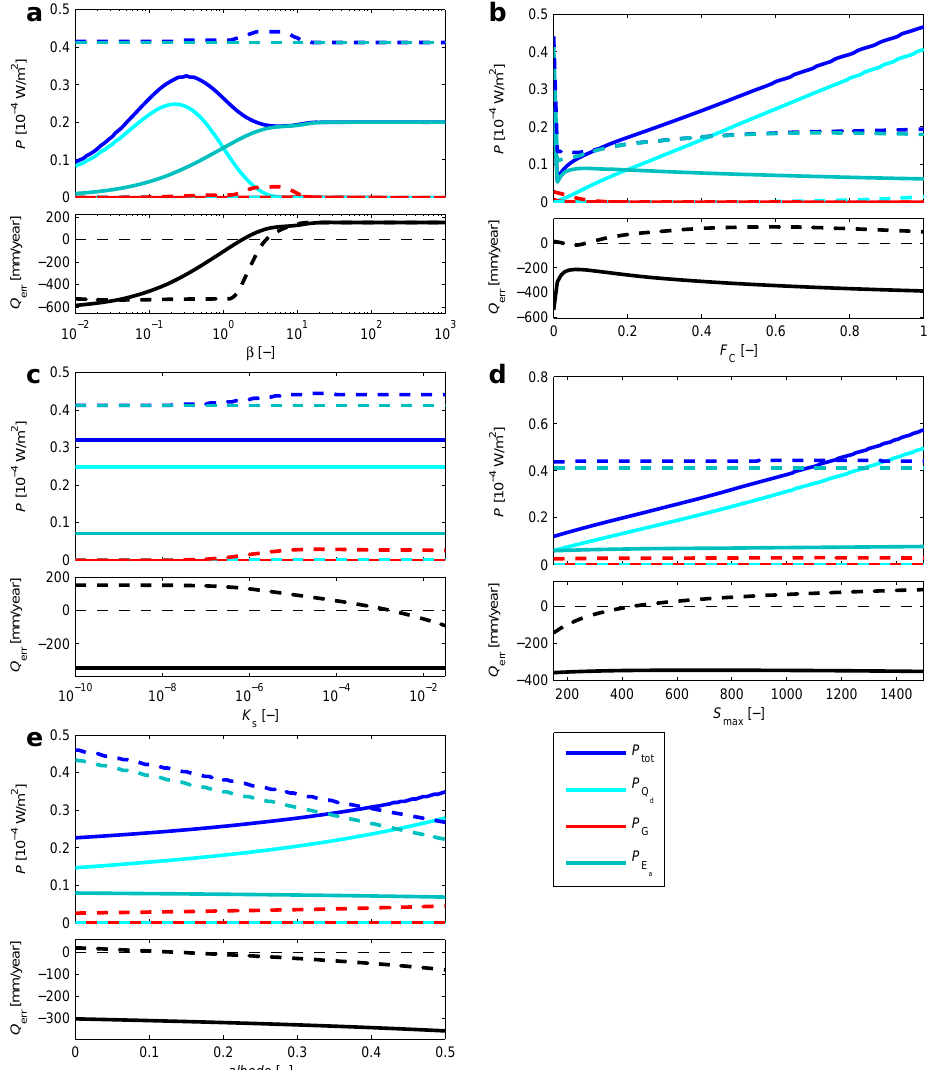
Fig. 3. Sensitivity of (a) β , (b) F C , (c) K s , (d) S max and (e) albedo to power of the different fluxes leaving the unsaturated zone and associated mass balance error for the Weiherbach catchment. Total power is plotted in blue, power by Q d in light cyan, power by G in red and power by E a in dark cyan. The dotted and dashed lines represent two different parameter sets (see Table